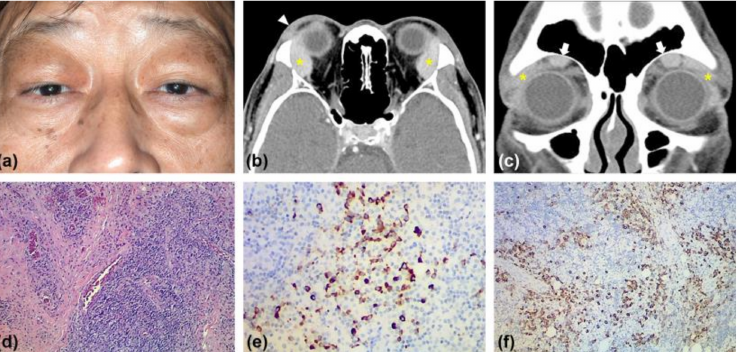
Figure 1. ( a ) Clinical appearance before surgery with bilateral upper eyelid swelling and a palpable mass over the right lacrimal fossa. ( b ) Contrast-enhanced axial computed tomography (CT) of the orbits revealed bilateral enlargement of the lacrimal gland (asterisk) and right upper eyelid’s homogenous enhancement with an irregular border (arrowhead). ( c ) Contrast-enhanced coronal CT of the orbits revealed bilateral enlargement of the lacrimal gland (asterisk) and supraorbital nerve (arrows). ( d ) Hematoxylin-eosin (H&E) staining demonstrated storiform fibrosis with diffuse lymphoplasmacytic infiltrate. ( e ) IgG4 immunohistochemical staining revealed >50 IgG4+ plasma cells /high power field and IgG4+/IgG+ ratio of >40% in the plasma cells infiltration. ( f ) Plasma cell immunohistochemical staining was positive for CD